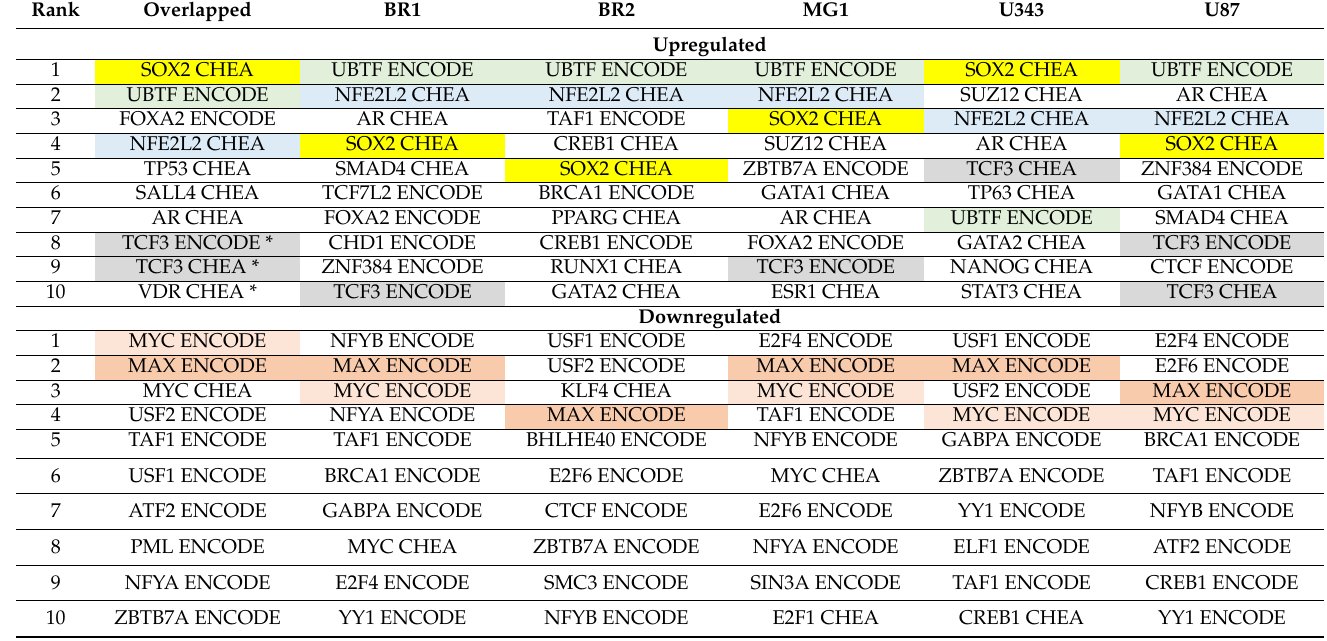
Table 3. Transcription factors controlling gene expression during NS formation determined using Enrichr. Top 10 Enrichr records (library “ENCODE and ChEA Consensus TFs from ChIP-X”), ordered by descending p -value (with adjusted p -value < 0.05), for each particular MN/NS pair as well as for the list of overlapping up/downregulated genes. Common top transcription factors for comparison pairs are highlighted in